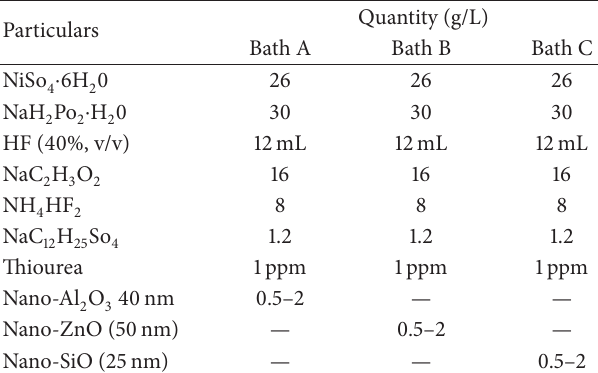
Table 2: Compositions of coating bath for electroless Ni–P used in the